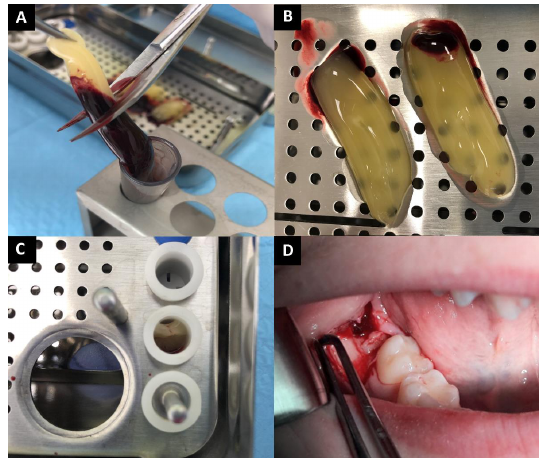
Figure 1. ( A ) Removing A-PRF clot from the tube; ( B ) A-PRF clots after remove from the tubes; ( C ) A-PRF corks preparation; ( D ) A-PRF application. 2.2. Surgical Procedure Before the surgery, local anesthesia was given via injection. Mandibular and buccal blocks were administered using 1.7 mL 4% articaine hydrochloride containing 1:100,000 epinephrine (Citocartin 100, Molteni Dental s.r.l., Scandicci (Florence), Italy). Triangle incision was made with no. 15 scalpel blade and the mucoperiosteal flap was raised. The osteotomy was performed using a round bur mounted on a W&H implanted surgical low-